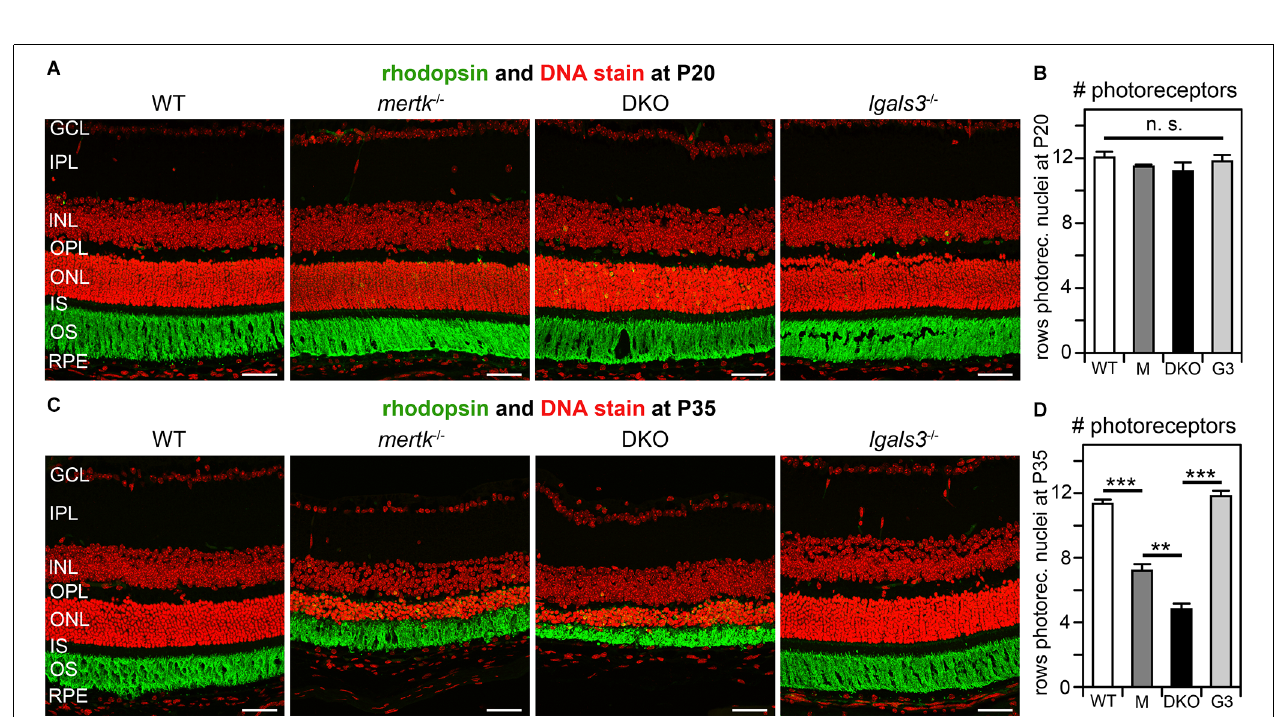
FIGURE 3 | Galectin-3 deficiency in mice lacking MERTK exacerbates photoreceptor degeneration. Dissected eyeballs from WT, mertk -/- , DKO, and lgals3 -/- mice at P20 (A,B) or P35 (C,D) were processed for sectioning and immunofluorescence microscopy. Representative fields in (A,C) show photoreceptor outer segment marker rhodopsin (green) and nuclei counterstain (red). Retinal layers are also marked as follows: GCL, ganglion cell layer; IPL, inner plexiform layer; INL, inner nuclear layer; OPL, outer plexiform layer; ONL, outer nuclear layer; IS, photoreceptor inner segments; OS, photoreceptor outer segments; RPE. All scale bars: 40 µ m. Bars in (B,D) show numbers of rows of photoreceptor nuclei with reduction indicative of photoreceptor degeneration at P35 and counted in images as in (A,C) . Bars show mean ± s. d.; n = four biological samples from four different mice for each genotype, white bars, WT; dark gray bars, mertk -/- (M); black bars, DKO; light gray bars, lgals3 -/- . Data were analyzed by ANOVA; n. s., ANOVA showed no significant difference; no post-hoc testing was performed. Select differences established by post-hoc testing are indicated, ** p < 0.01; *** p <